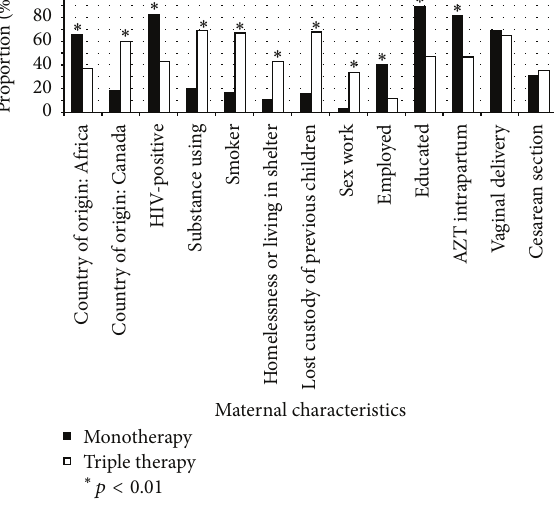
Table 2: Summary of neonatal demographics.